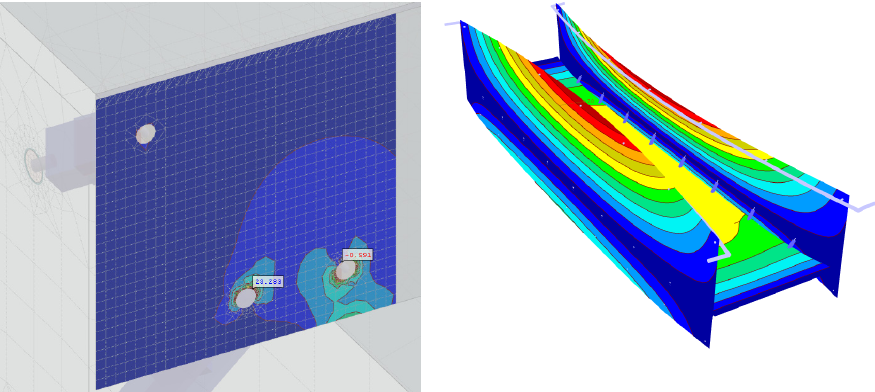
Figure 7: Maximum principal stresses in cross beam at connection.